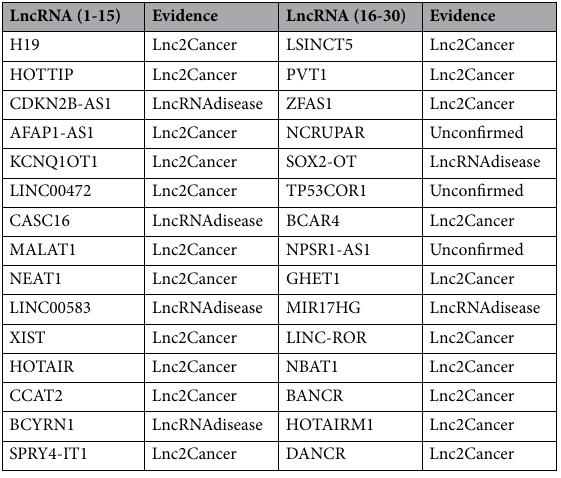
Table 3. The top 30 predicted lncRNAs associated with breast